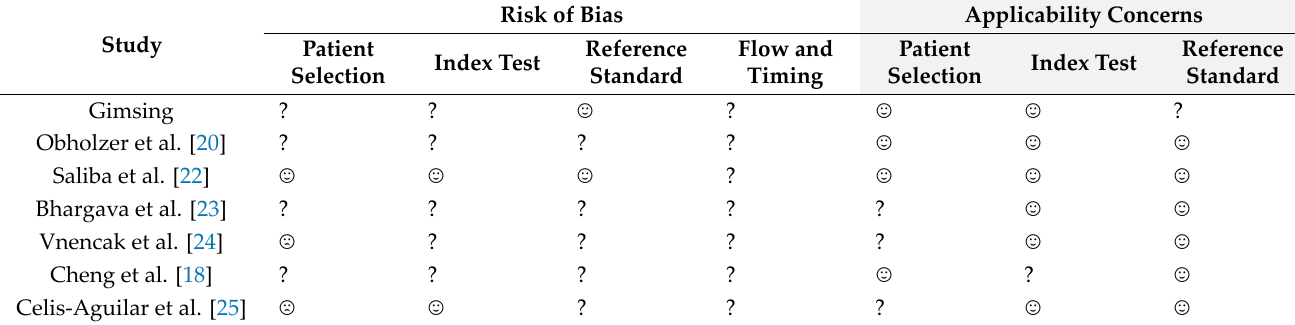
Table 2. Quality assessment of the included studies.